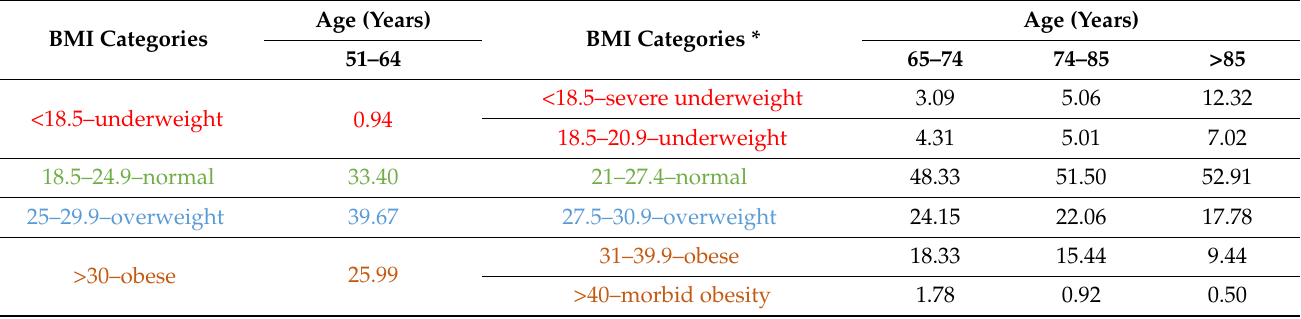
Table 3. Frequency and percentage of the Body Mass Index (BMI), regarding the defined categories based on